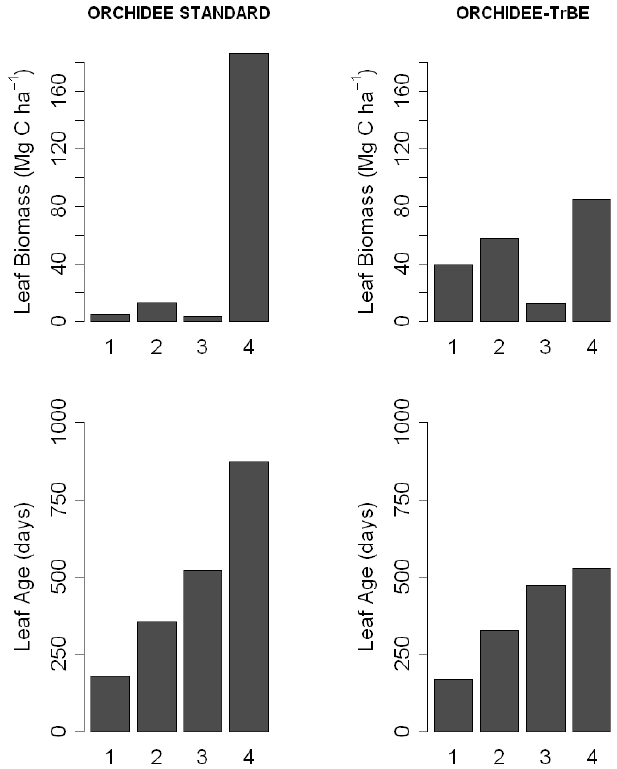
Fig. 7. Leaf biomass and leaf age distribution by leaf age class at Guyaflux for ORCHIDEE-STAND and